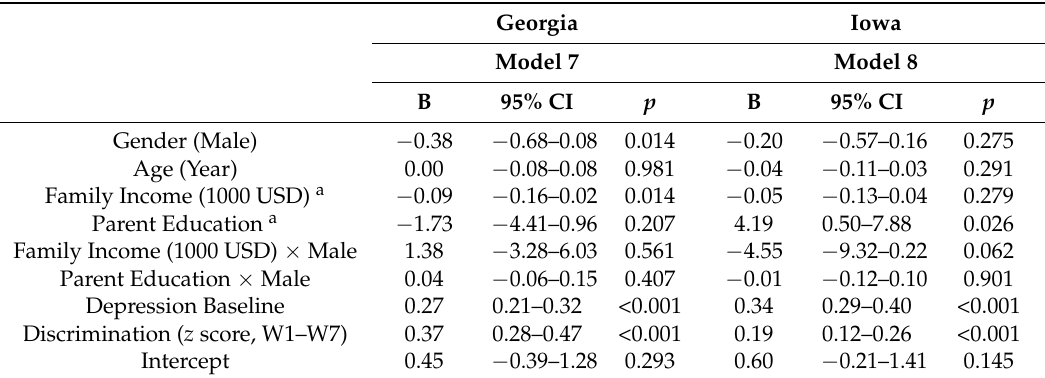
Table 6. Summary of linear regressions on the interactive effects of SES, gender, and discrimination on average depressive symptoms over 18 years by place ( n =